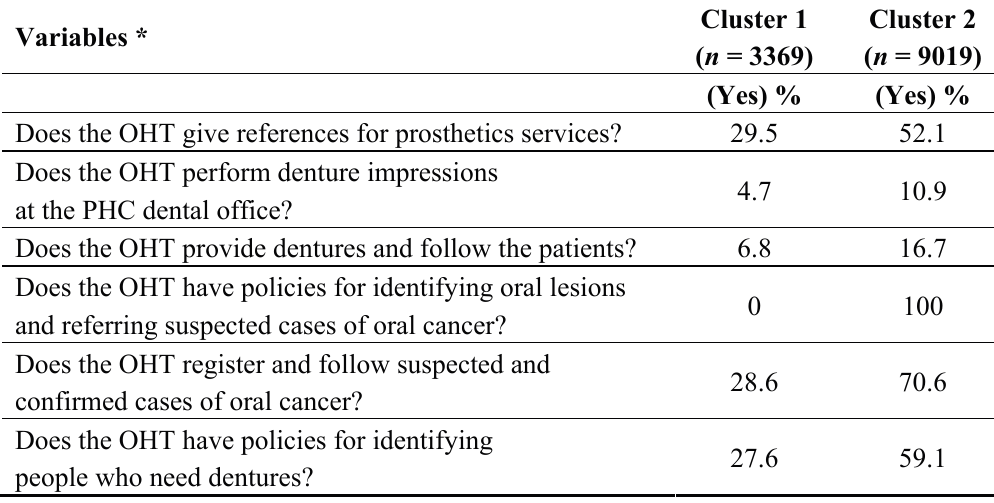
Table 4. Primary healthcare actions related to oral cancer and dental prostheses/dentures in the two clusters in Brazil,